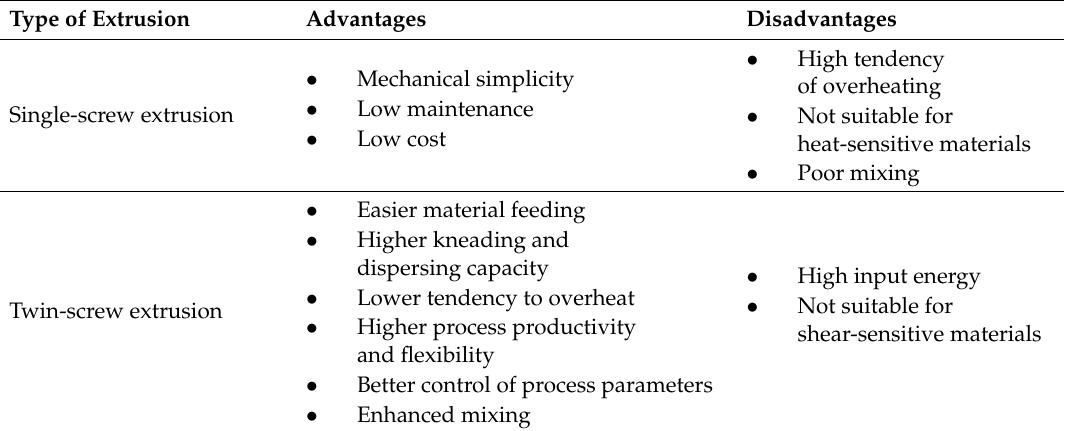
Table 1. Advantages and disadvantages of single-screw and twin-screw